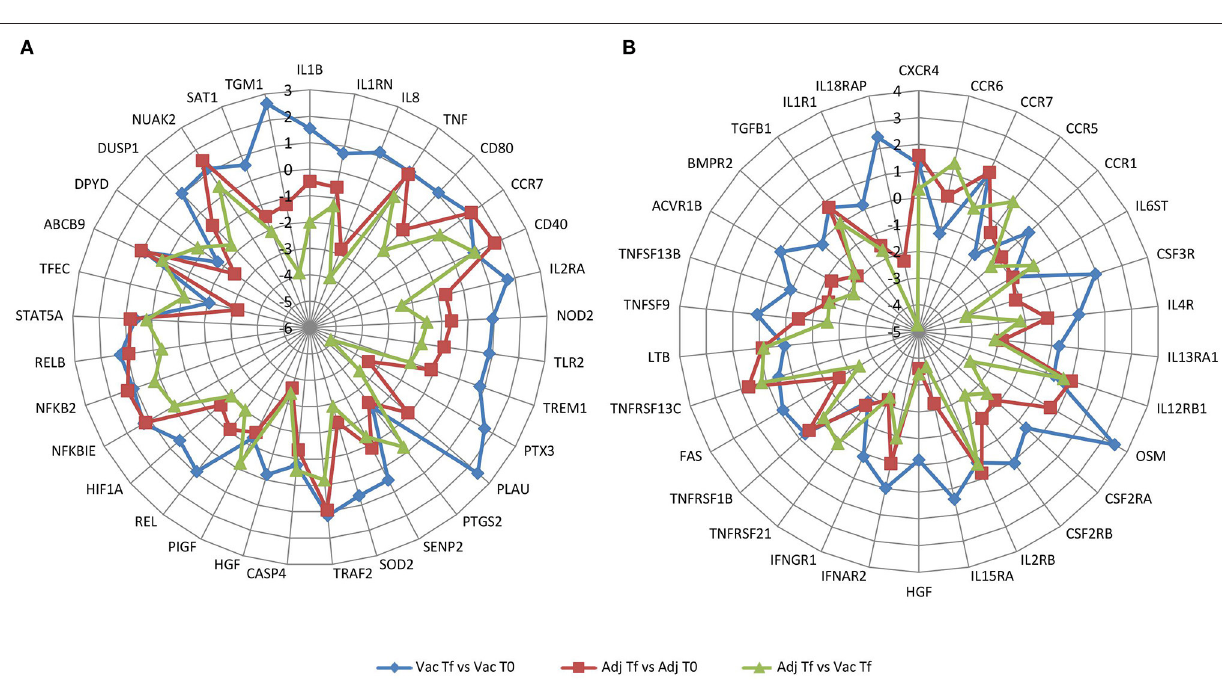
FIGURE 8 | Radar plot with the log 2 (FoldChange) of overrepresented genes in (A) NF- κ B signaling pathway and in (B) cytokine-cytokine receptor interaction pathway in the Vac Tf vs. Vac T0 (blue), Adj Tf vs. Adj T0 (red), and Adj Tf vs. Vac Tf (green)